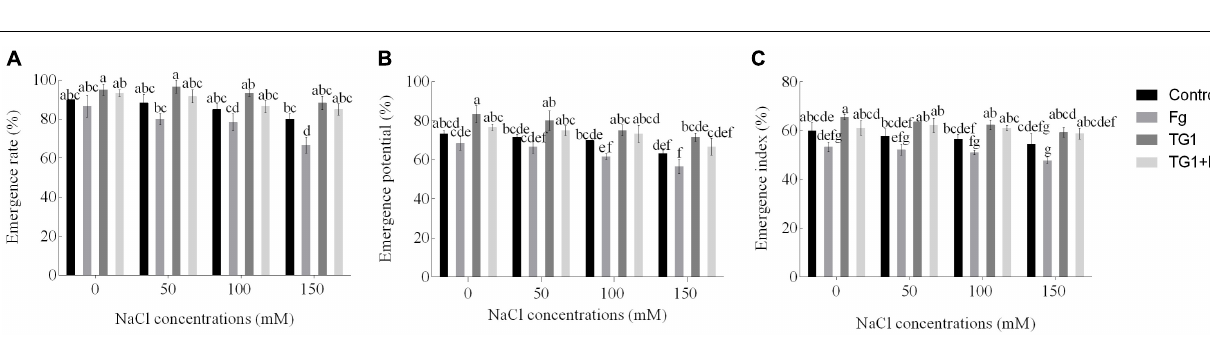
FIGURE 5 | Effect of T. longibrachiatum (TG1) on wheat seeds (A) emergence rate, (B) emergence potential, and (C) emergence index under F. pseudograminearum (Fg) and salt stress. Different lower case letters indicate significant differences at P < 0.05 in Duncan’s multiple range test using two-way ANOVA. Emergence rate, potential, and index were determined after treatment, respectively. Control treatments represent wheat seedlings pretreated with distilled water only; TG1 represents wheat seeds pretreated with the suspension of T. longibrachiatum (TG1); TG1 + Fg represents wheat seeds pretreated with T. longibrachiatum (TG1) and F. pseudograminearum (Fg); and Fg represents wheat seeds pretreated with F. pseudograminearum (Fg) for 12 h before planting with different NaCl treatments (0, 50, 100, and 150